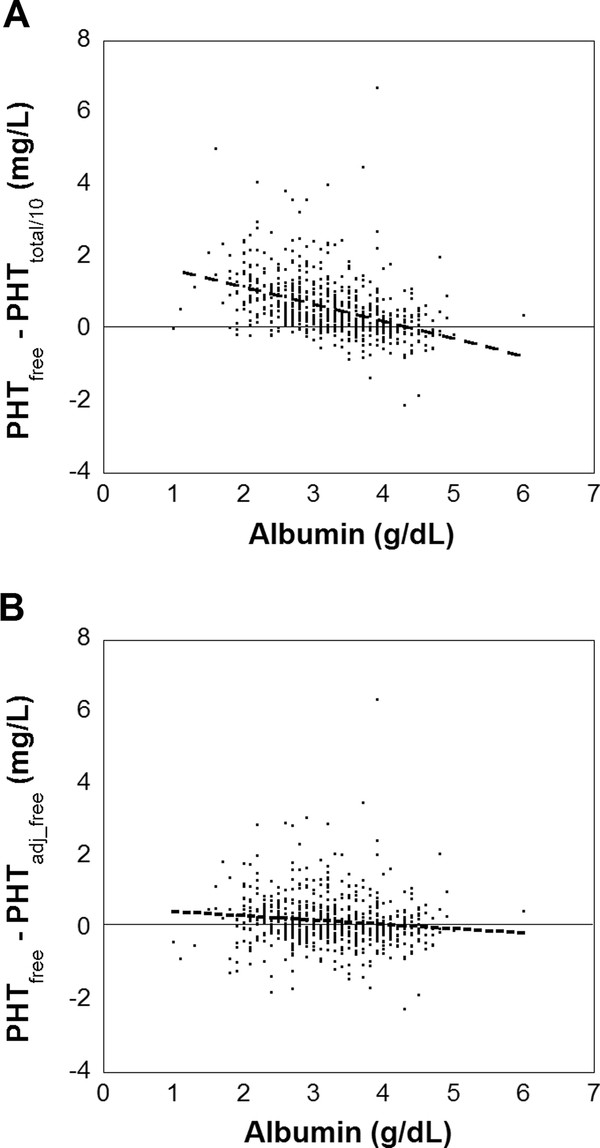
Variation of total phenytoin, adjusted phenytoin, and free phenytoin with respect to plasma albumin concentration. (A) Variation of the difference between PHTtotal/10 and PHTfree with respect to plasma albumin concentration. All data is from chronologically first phenytoin measurements in 756 patients. The dashed line is from linear regression: [PHTtotal/10 - PHTfree] = -2.136 + 0.477 * [albumin concentration] (R2 = 0.19). The 95% confidence intervals of the intercept is (-2.37, -1.90) and for the slope is (0.406, 0.549). (B) Variation of the difference between PHTfree and PHTadj_free with respect to plasma albumin concentration using same source of patient data in (A). The dashed line is from linear regression: [PHTfree - PHTadj_free] = 0.0838 + 0.0021*[plasma albumin] (R2 = 0.004). The 95% confidence intervals of the intercept is (-0.138, 0.305) and for the slope is (-0.0649, 0.0691)